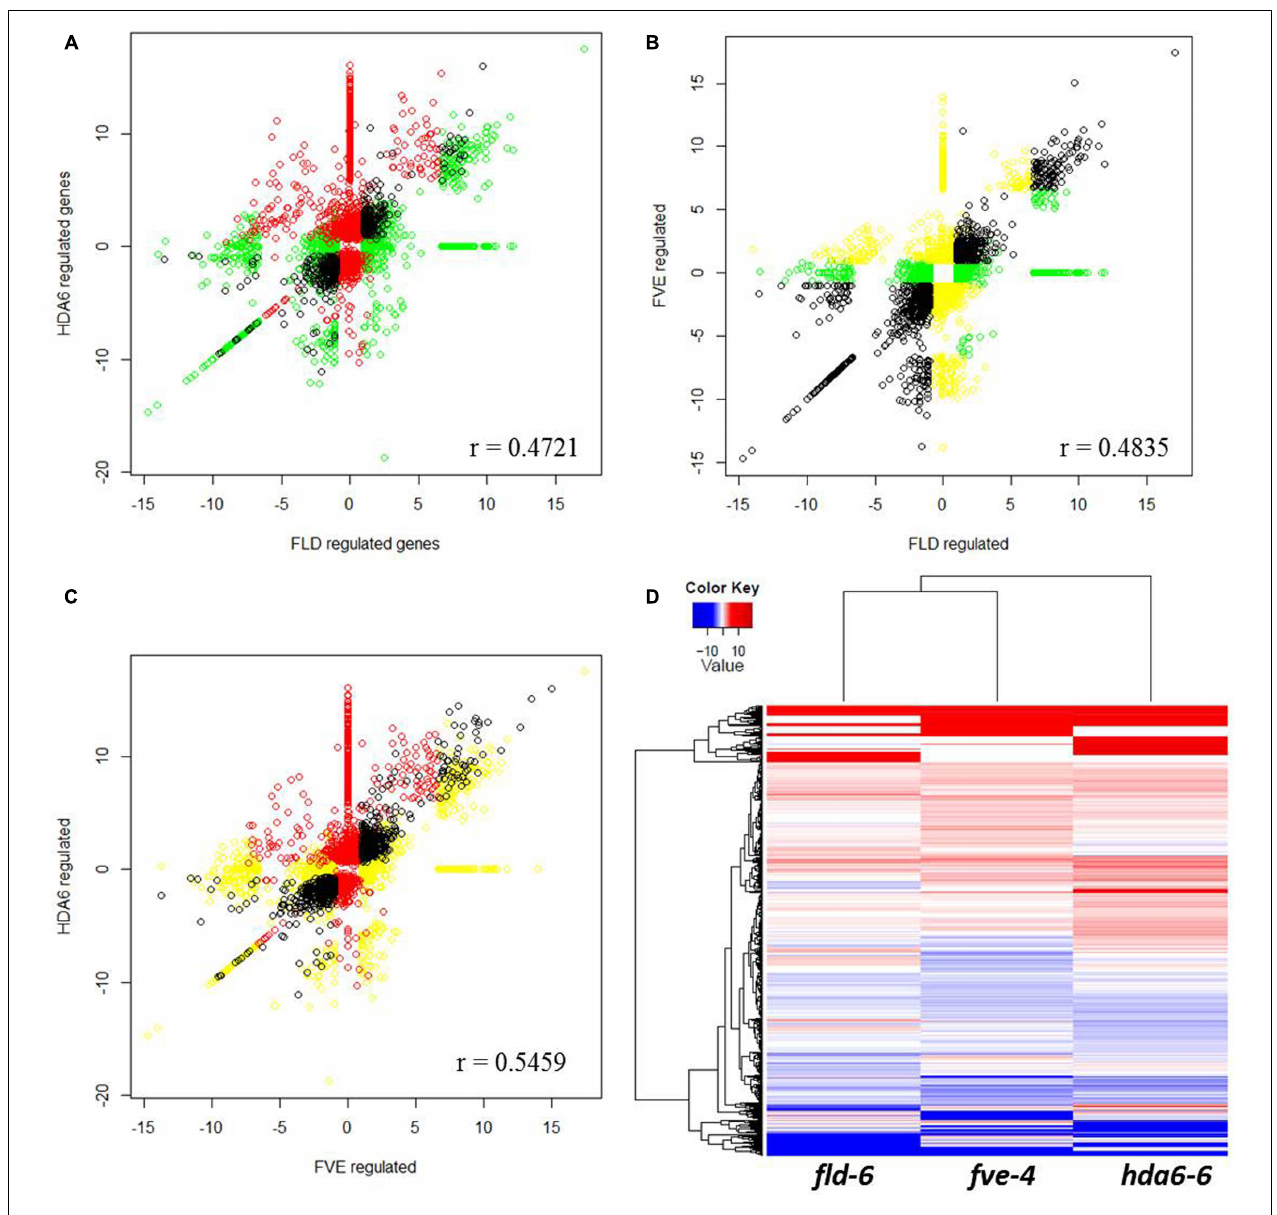
FIGURE 6 | Scatterplot analysis of FVE, FLD, and HDA6 regulated genes. (A–C) Correlation by scatterplot of log2 fold change values between HDA6 and FLD regulated genes (A) , FVE and FLD regulated genes (B) and HDA6 and FVE regulated genes (C) . Correlation coefficient was calculated and shown in figure. (D) Transcriptional profiles comparisons represented as a heatmap to highlight up-regulated (red) and down-regulated (blue) genes in fve-4 , fld-6 , and hda6-6